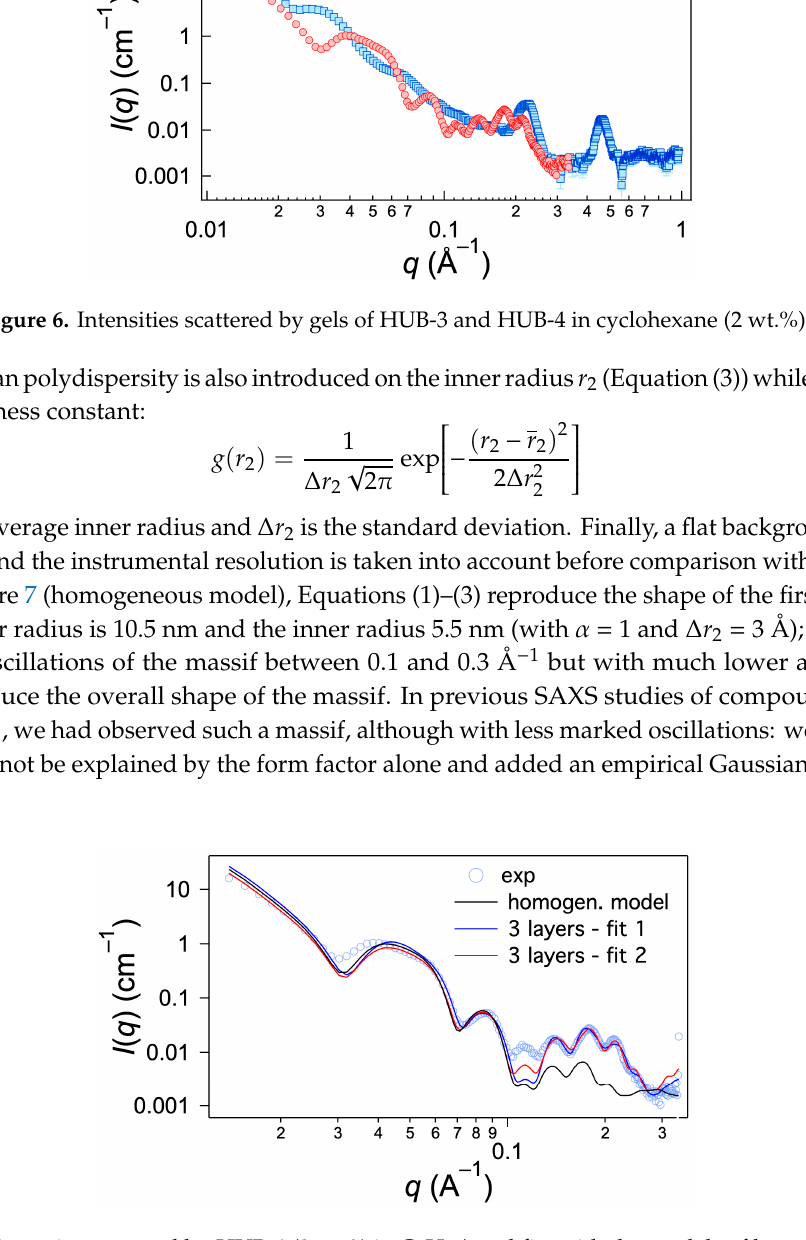
B Figure 8. Model of tube with three layers. ( A ) definition of the different radiuses; ( B ) radial scattering length density profile ρ ( r ). The intensity scattered by these tubes is given by Equation (4): (cid:1835)((cid:1869)) = (cid:2038) (cid:3023) 4(cid:2024) (cid:2870) ((cid:1870) (cid:2869)(cid:2870) − (cid:1870) (cid:2872)(cid:2870) ) 1 (cid:1869) (cid:2871) (cid:3427)(cid:1870) (cid:2869) ((cid:2025) (cid:2869) − (cid:2025) (cid:3046) ) (cid:1836) (cid:2869) ((cid:1869)(cid:1870) (cid:2869) ) + (cid:1870) (cid:2870) ((cid:2025) (cid:2870) − (cid:2025) (cid:2869) ) (cid:1836) (cid:2869) ((cid:1869)(cid:1870) (cid:2870) ) + (cid:1870) (cid:2871) ((cid:2025) (cid:2871) − (cid:2025) (cid:2870) ) (cid:1836) (cid:2869) ((cid:1869)(cid:1870) (cid:2871) ) + (cid:1870) (cid:2872) ((cid:2025) (cid:3046) − (cid:2025) (cid:2871) ) (cid:1836) (cid:2869) ((cid:1869)(cid:1870) (cid:2872) )(cid:3431) (cid:2870)